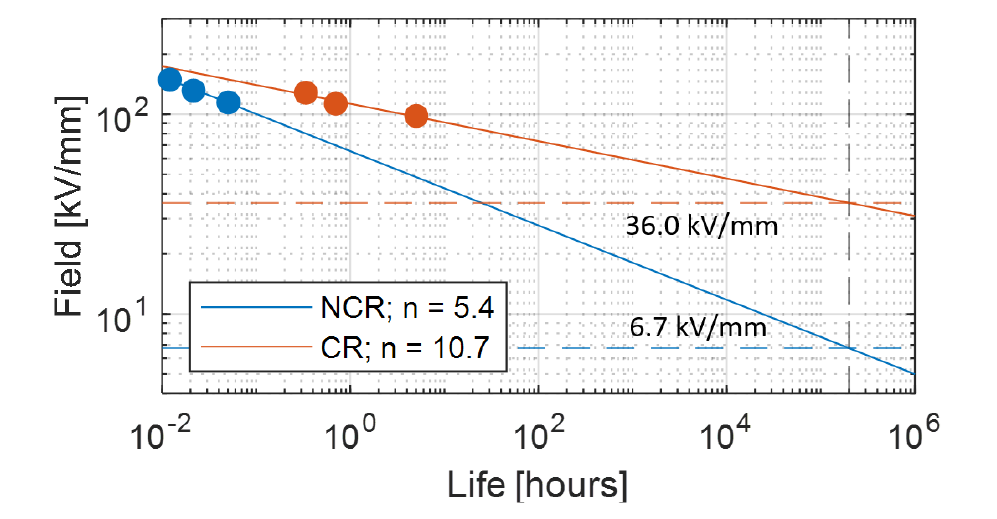
Figure 3. Life lines under PD and at failure probability 1% (Equation (1)) for non-corona-resistant material (NCR) and a corona resistant one (CR). The results of accelerated life tests (until break- down) are reported, representing the failure time at failure probability 1% derived from the Weibull distribution of breakdown times (Equation (2)). The horizontal lines indicate the design field, E D , corresponding to the life of 2 × 10 5 h (vertical dotted line) at failure probability